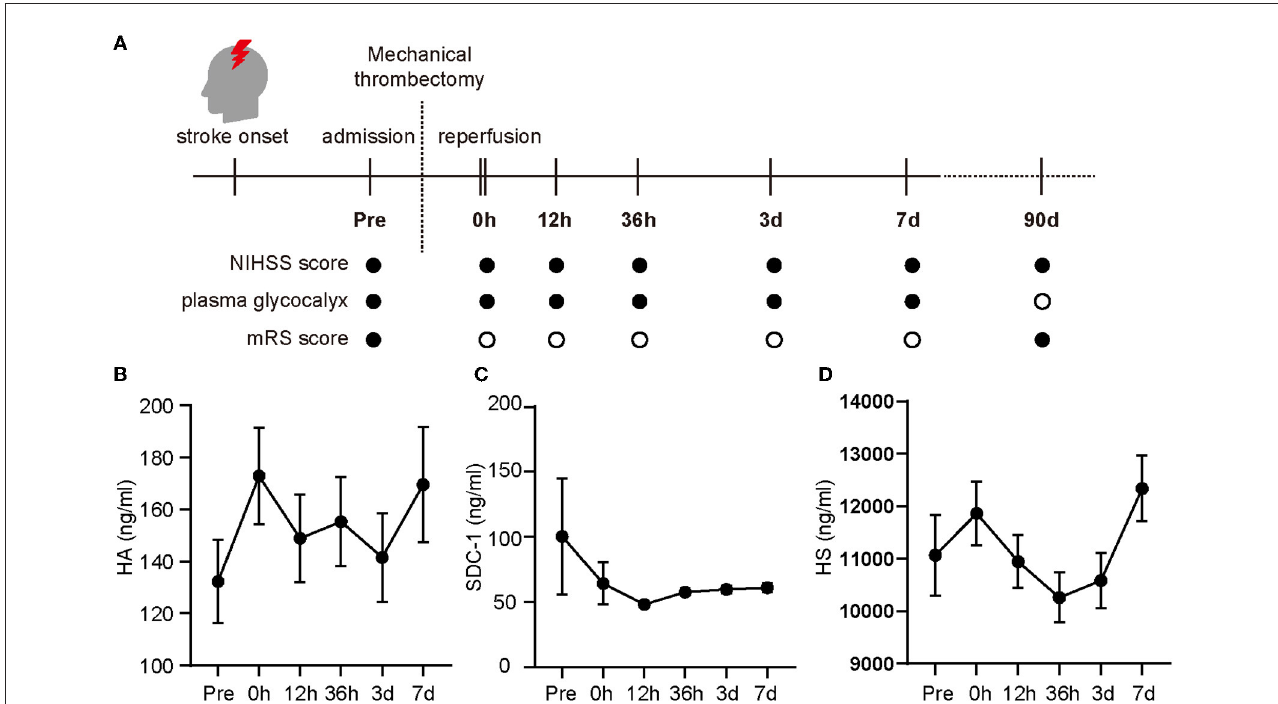
FIGURE1 Changes in glycocalyx components in the plasma of patients enrolled in the study. The evaluation index and multiple time points (pre-operation (referred to as “Pre” in the figure), 0h, 12h, 36h, 3 days, and 7 days after the operation) during the investigation are shown in (A) (• for evaluation, ◦ for no evaluation) and the glycocalyx concentrations in the plasma are shown from (B–D) . Differences between groups were compared using a linear mixed model. NIHSS, National Institute of Health Stroke Scale; mRS, modified Rankin Scale; HA, hyaluronic acid; SDC-1, syndecan-1; HS, heparan